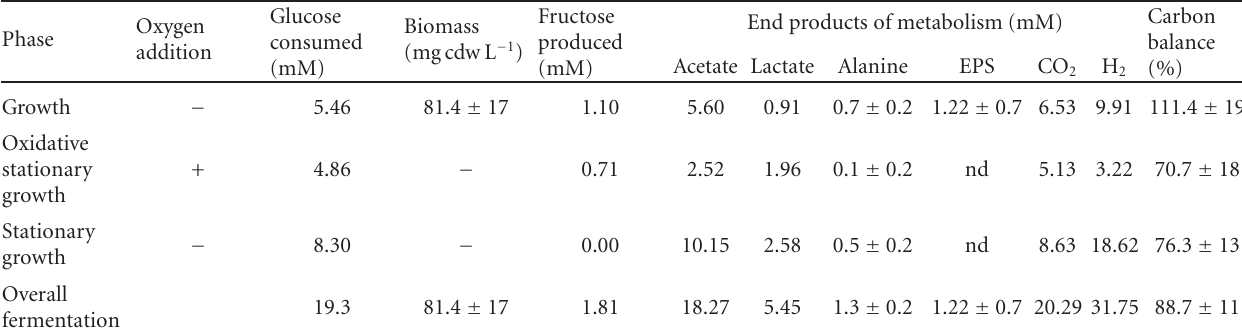
Table 2: Batch balance for Thermotoga maritima grown on BM under anoxic conditions including the oxidative